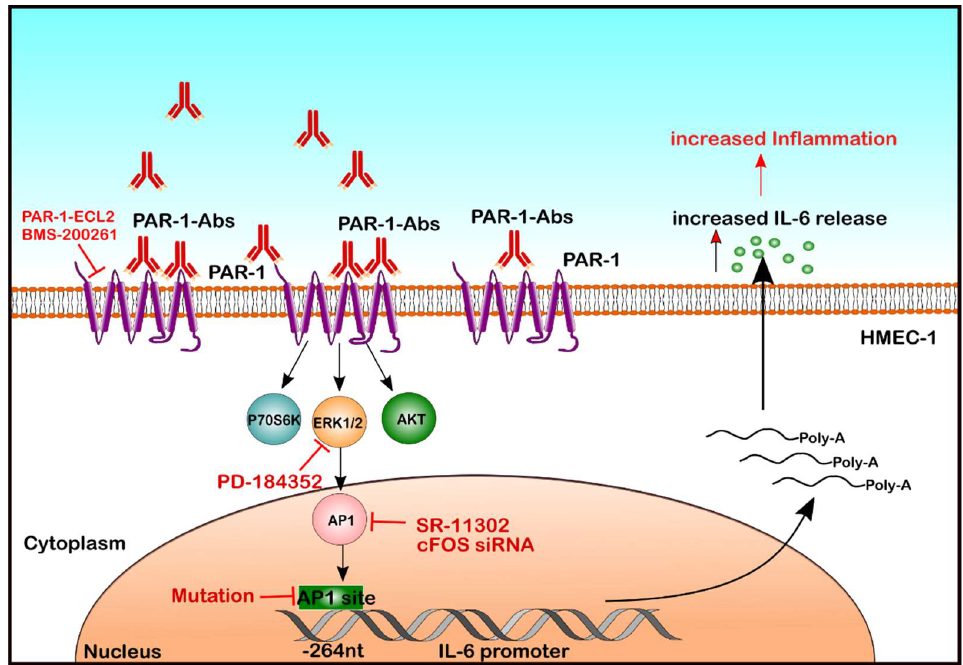
Figure 1. Molecular mechanisms underlying endothelial IL-6 release in response to autoantibodies from patients with SRC. Here, we demonstrate that autoantibodies present in SRC patients can activate GPCRs on EC and engage a signalling cascade involving PAR-1, PI3K/mTOR/ERK1/2 and AP-1/c-FOS to activate the IL-6 promoter (Position -264 nucleotides from the IL-6 gene), which leads to IL-6 mRNA expression and IL-6 protein release.